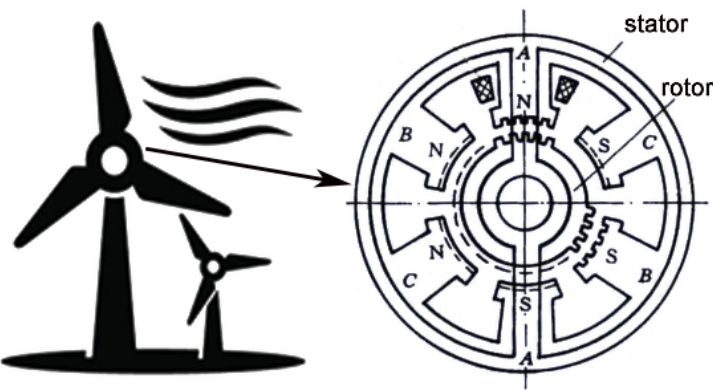
Figure 1. Schematic of common wind power generation principle.